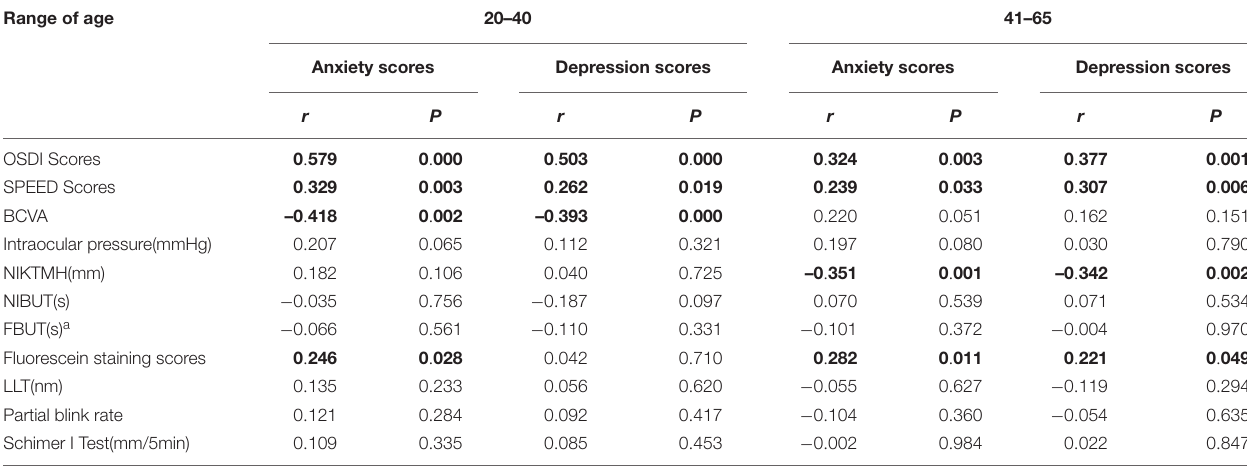
TABLE 5 | Correlation of dry eye symptoms and ophthalmic findings with psychological